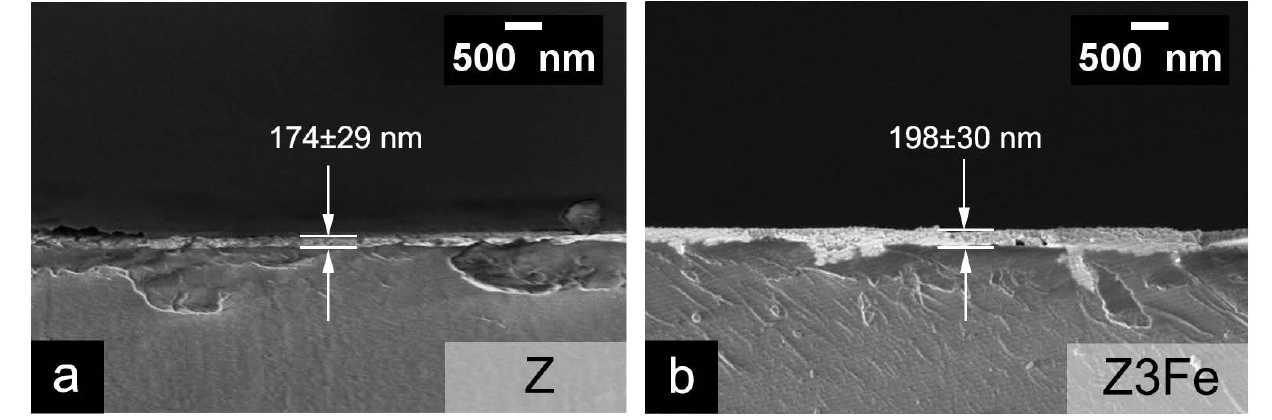
Figure 6. SEM microphotographs of chips of Z ( a ) and Z3Fe ( b ) samples on glass